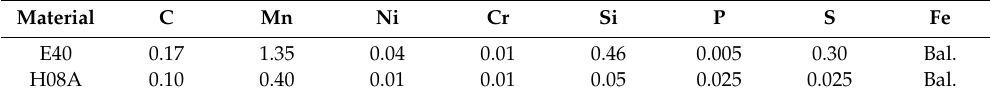
Table 1. Chemical composition of E40 and H08A steel.